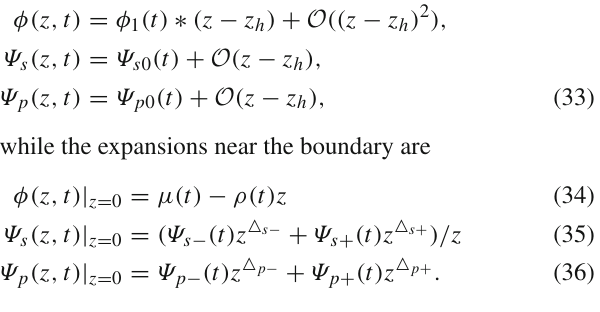
√ (cid:7) O (cid:8) . Cyan